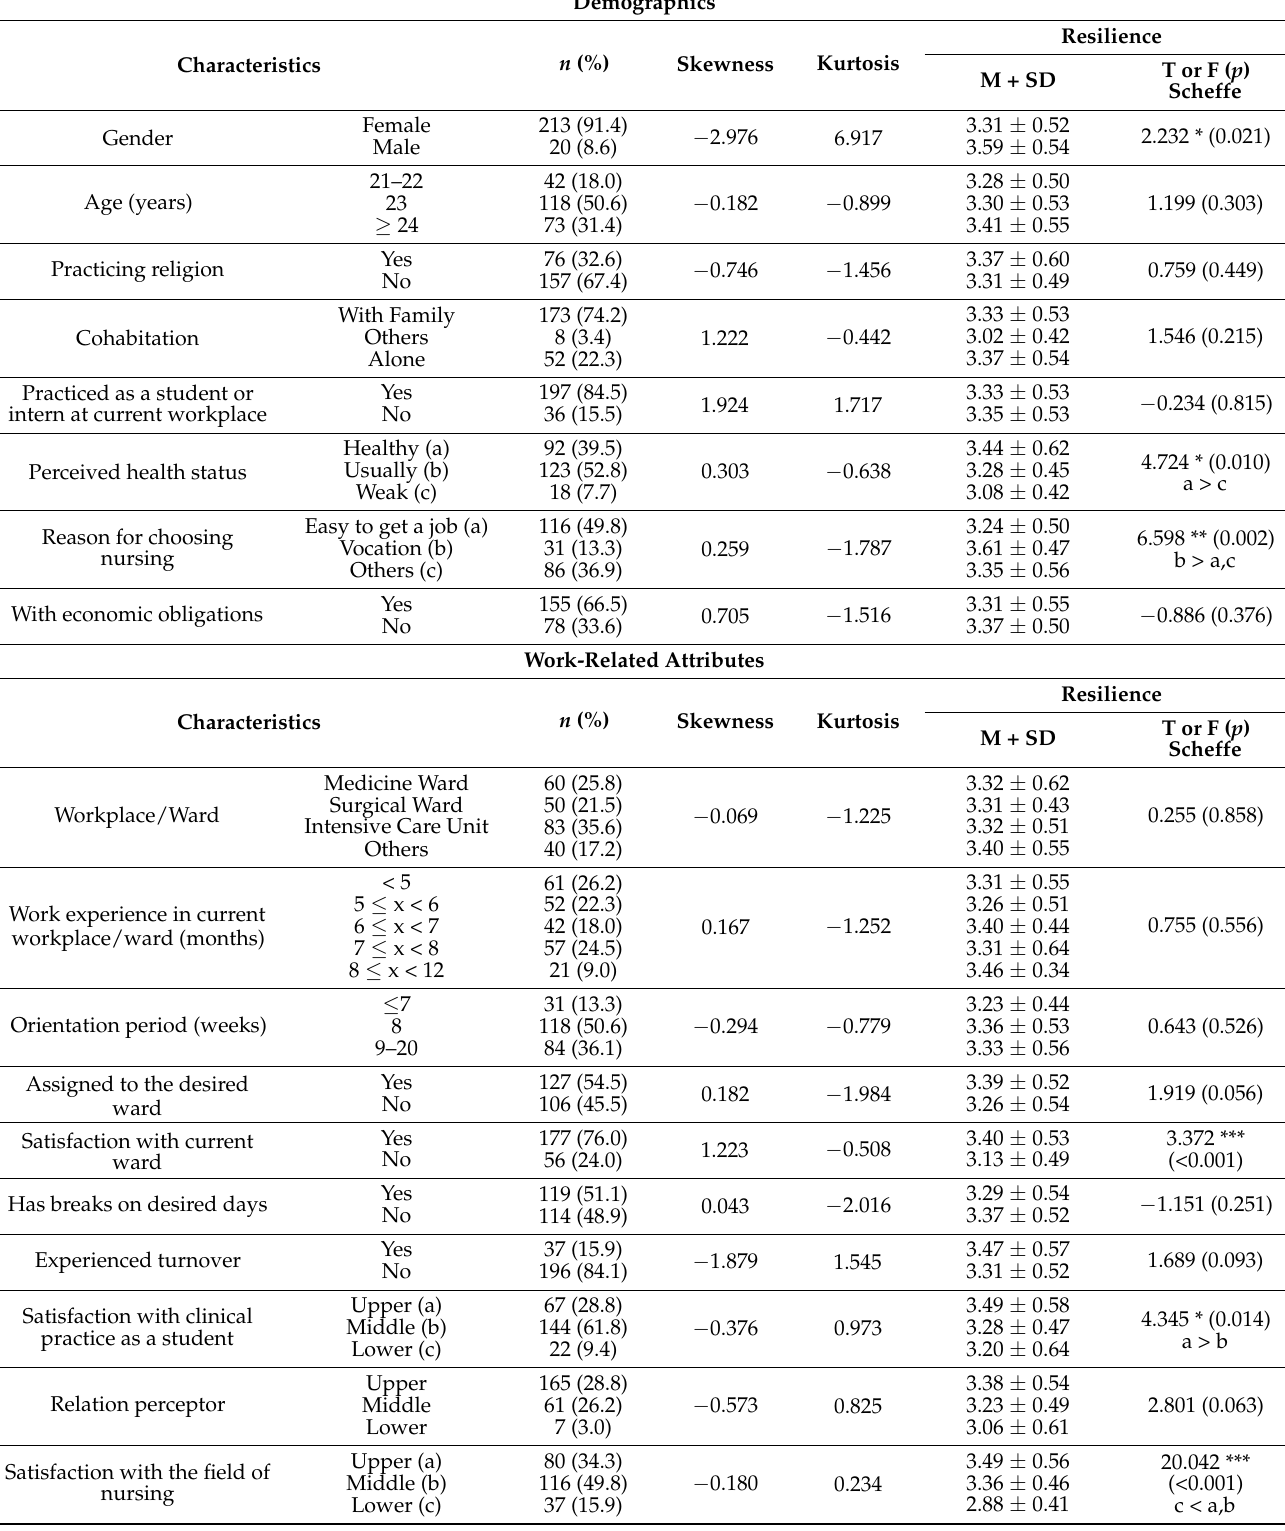
Table 1. Resilience according to the general characteristics ( n =